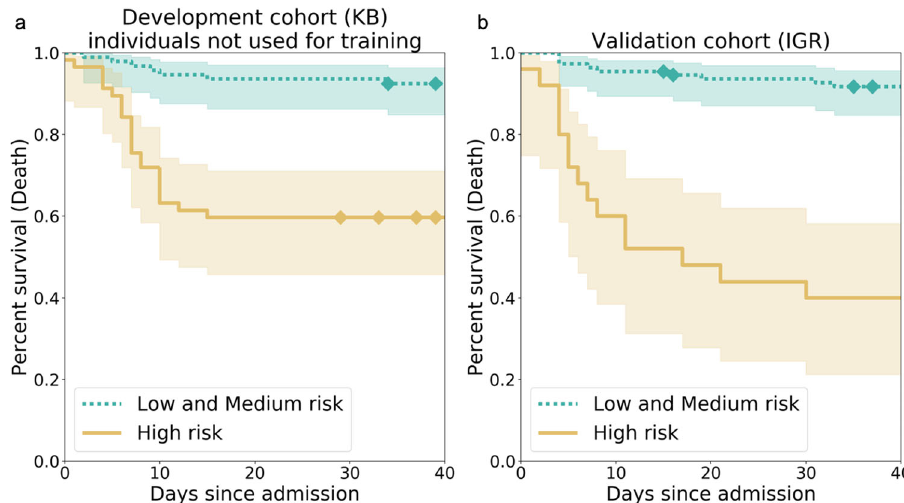
Fig. 1 Kaplan – Meier curves for the high-risk individuals and the ones with low or medium risk according to AI-severity. The threshold to assign individuals into a high-risk group was the 2/3 quantile of the AI-severity score computed for patients of the KB development cohort. a Kaplan – Meier curves were obtained for the 150 leftover KB patients from the development cohort. b Kaplan – Meier curves were obtained for the 135 patients of the IGR validation cohort. p -values for the log-rank test were equal to 4.77e – 07 (KB) and 4.00e – 12 (IGR). The two terciles used to determine threshold values for low-, medium-, and high-risk groups were equal to 0.187 and 0.375. Diamonds correspond to censoring of patients who were still hospitalized at the time when data ceased to be updated. The bands correspond to the sequence of the 95% con fi dence intervals of the survival probabilities for each day. KB